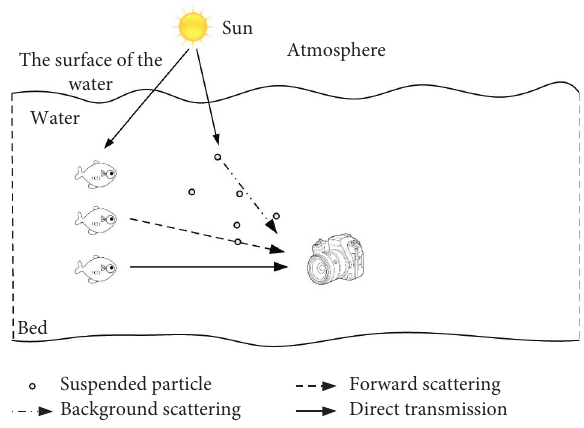
Figure 1: Diagram of light transmission in